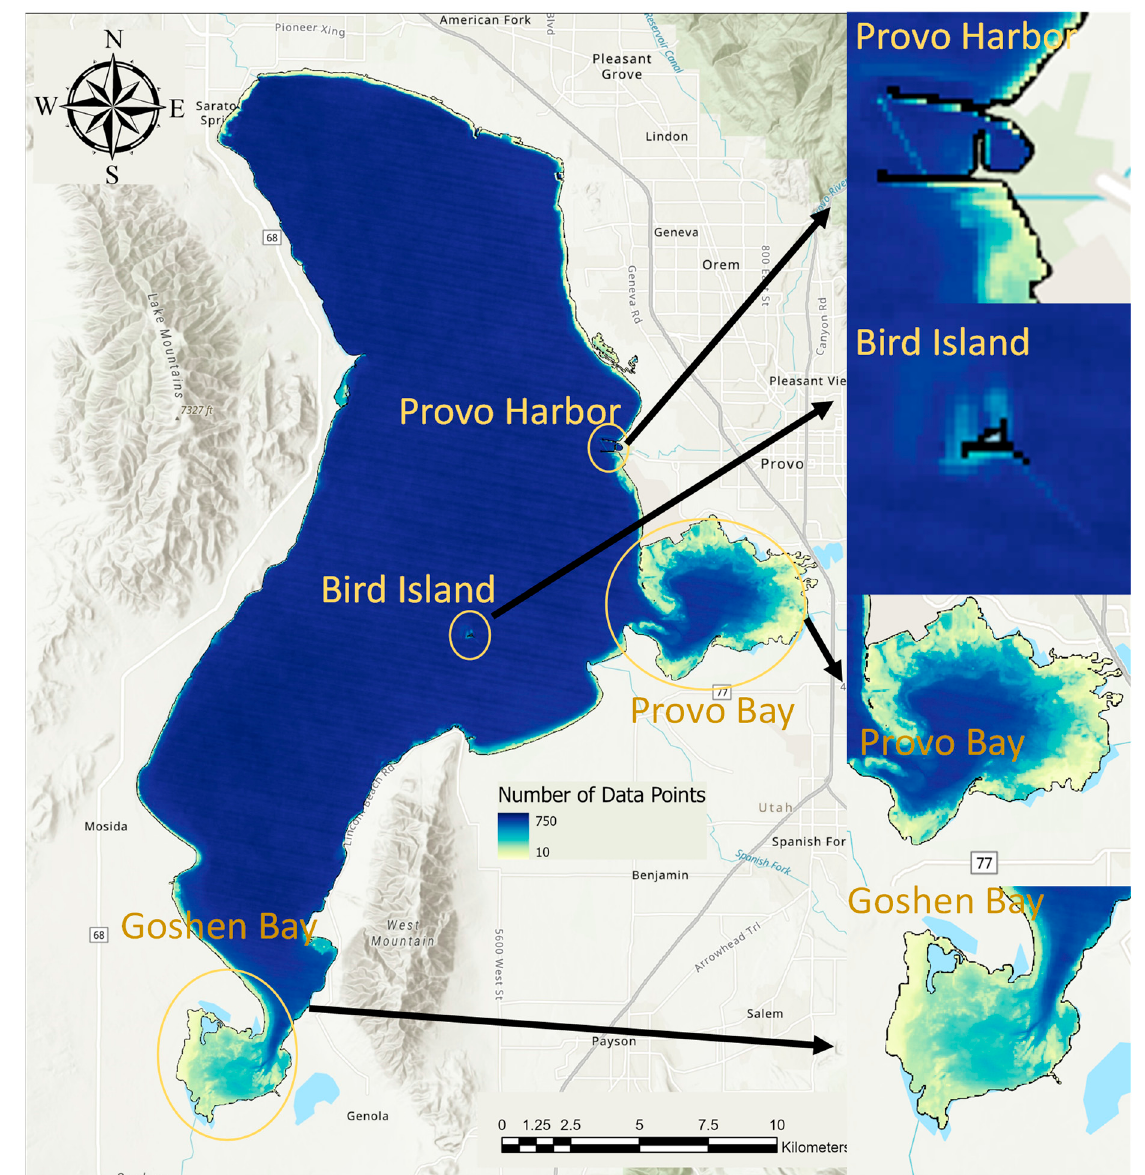
Figure 4. The left panel of this figure shows the number of pixels used in computing the mean, median, and standard deviation, and other summary statistics. The right panel shows details of some features demonstrating how water level changes impact the number of pixels over the long-term period.